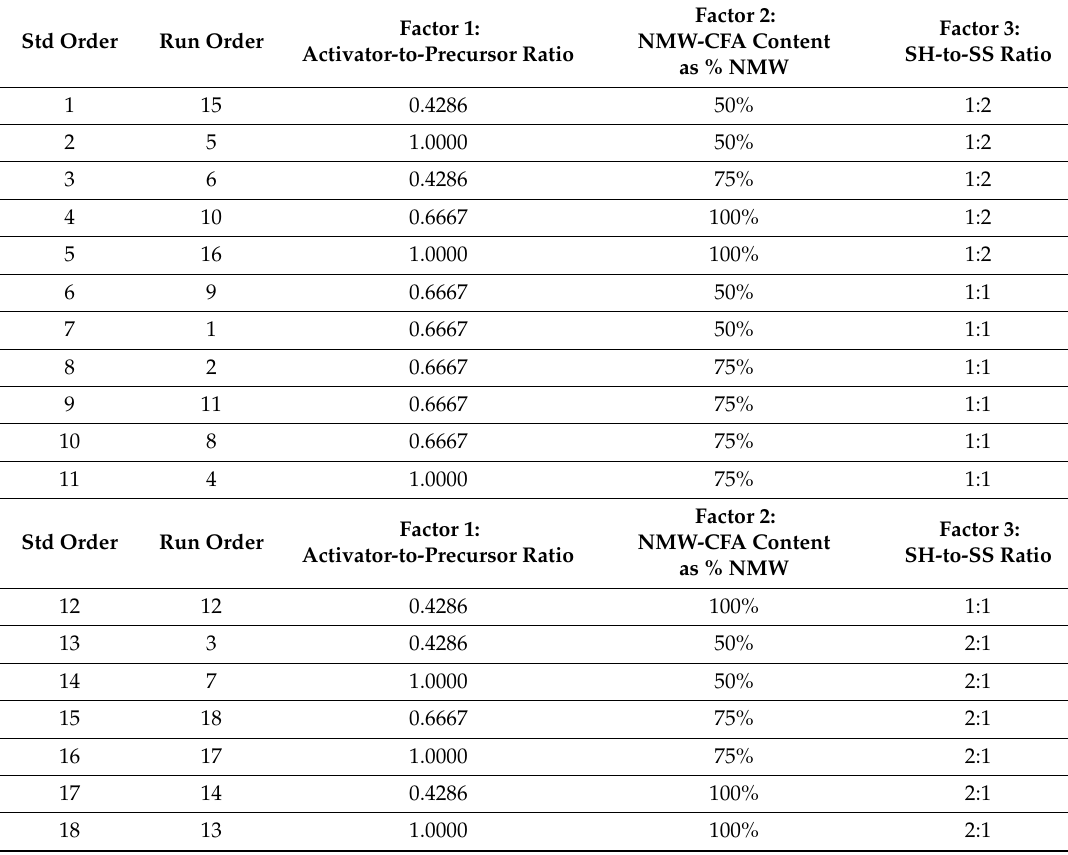
Table 2. Experimental runs in standard